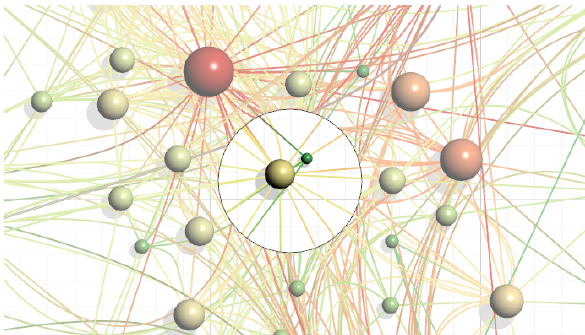
Figure 10. Circular lens within a network visualisation (CGV): in- creased saturation and removal of overlapping edges (see, as well, Tominski et al.,